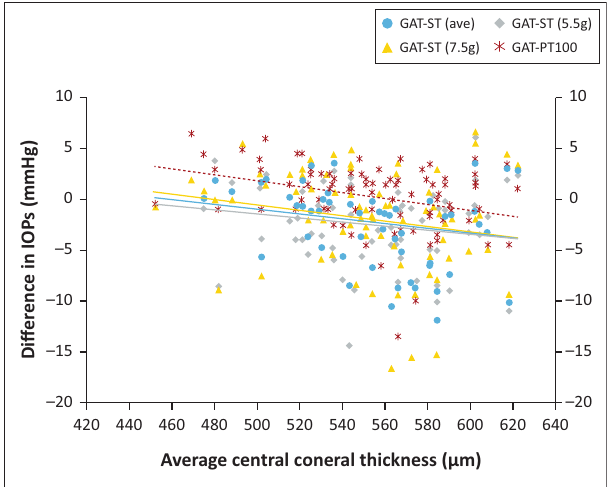
FIGURE 4: Limits of reproducibility for: (a) Goldmann applanation tonometer, (b) PT-100 noncontact tonometer, and (c), Schiøtz indentation tonometer intraocular pressure measurements in